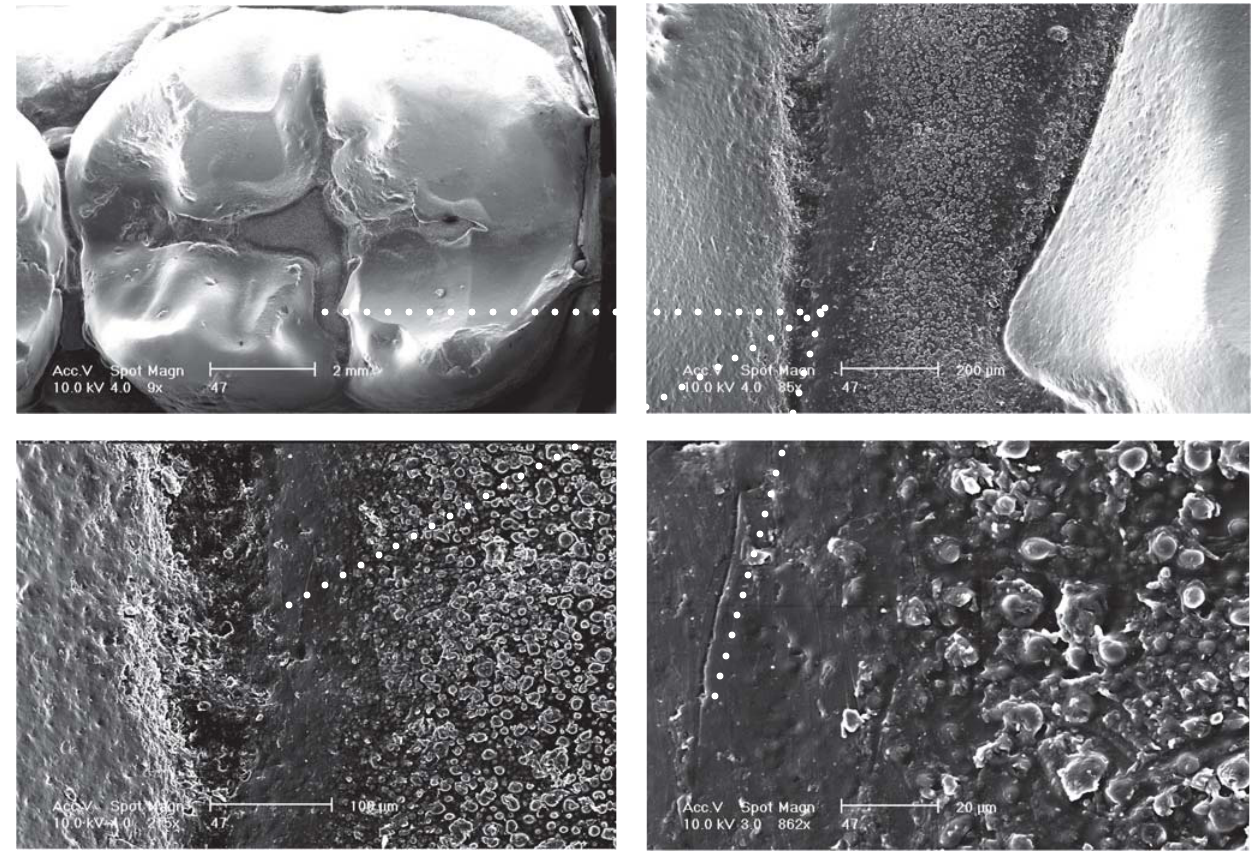
FIGURE 6- Various SEM magnification aspects of the altered glass-ionomer sealing of Figure